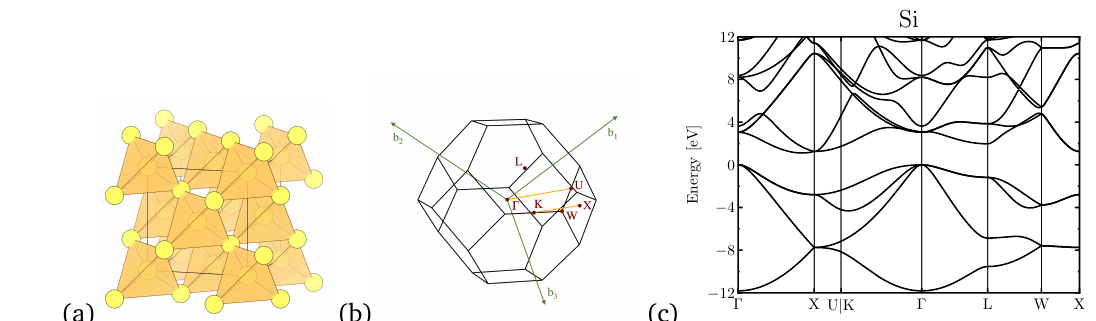
Figure 5: (a) Real-space face-centered cubic (FCC) lattice structure for Si (b) First ZnS Brillouin Zone for FCC crystal (c) Electron band structure for Si. The reciprocal = 2 π/ a ( − 1,1,1 ) , b = 2 π/ a ( 1, − 1,1 ) , and space primitive vectors are given by b 1 2 = 2 π/ a ( 1,1, − 1 ) . Γ labels the origin of the reciprocal space while the capital Ro- b 3 man letters indicate standard high-symmetry points in the BZ. Graphics reproduced from Ref. [ 42 ] , which also gives examples of additional crystals and target